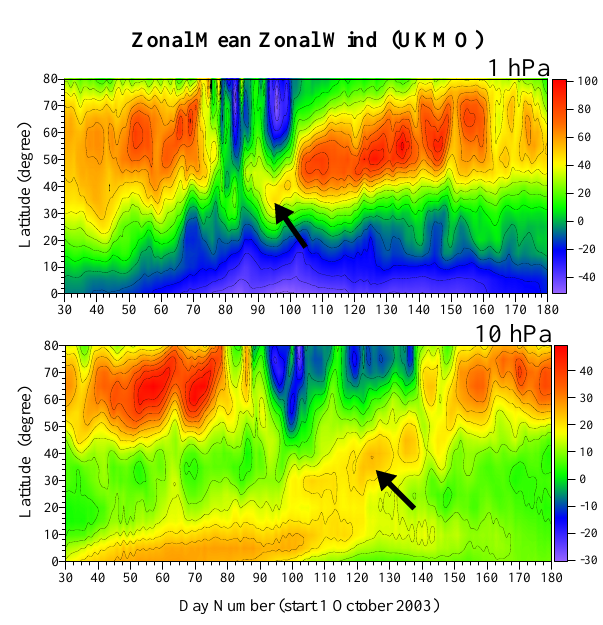
Figure 1 Fig. 1. Height-time cross sections of the zonal mean zonal wind in the stratosphere at pressure levels 10 and 1hPa during the period of time between November 2003 and March